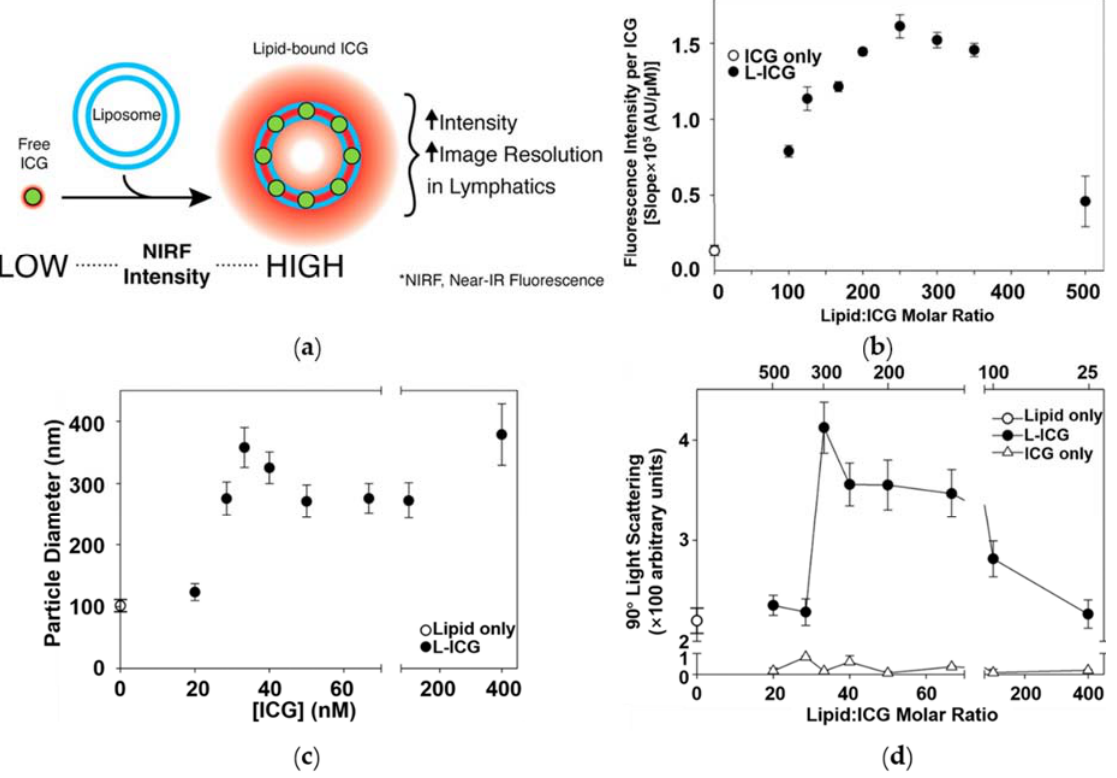
Figure 6. ( a ) Schematic illustration showing the preparation of lipid ‐ bound ICG (L ‐ ICG) and its effects; ( b ) Effects of lipid:ICG molar ratio on the fluorescence yield; ( c ) Effect of ICG concentration on the particle size analysis by photon correlation spectroscopy of liposomes; ( d ) Effect of ICG concentration on the 90° light scattering intensity of liposomes. A fixed concentration of liposomes was incubated with varying concentrations of ICG in a fixed volume. At 20 min, the mixtures were diluted to stop the reaction, and the 90° light scattering intensity was measured using a fluorometer. Reproduced from Ref. [38], with permission from American Chemical Society, 2014.